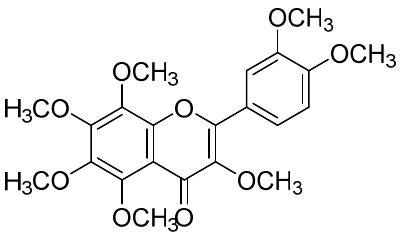
Figure 14. 3,5,6,7,8,3 ′ ,4 ′ -heptamethoxyflavone.